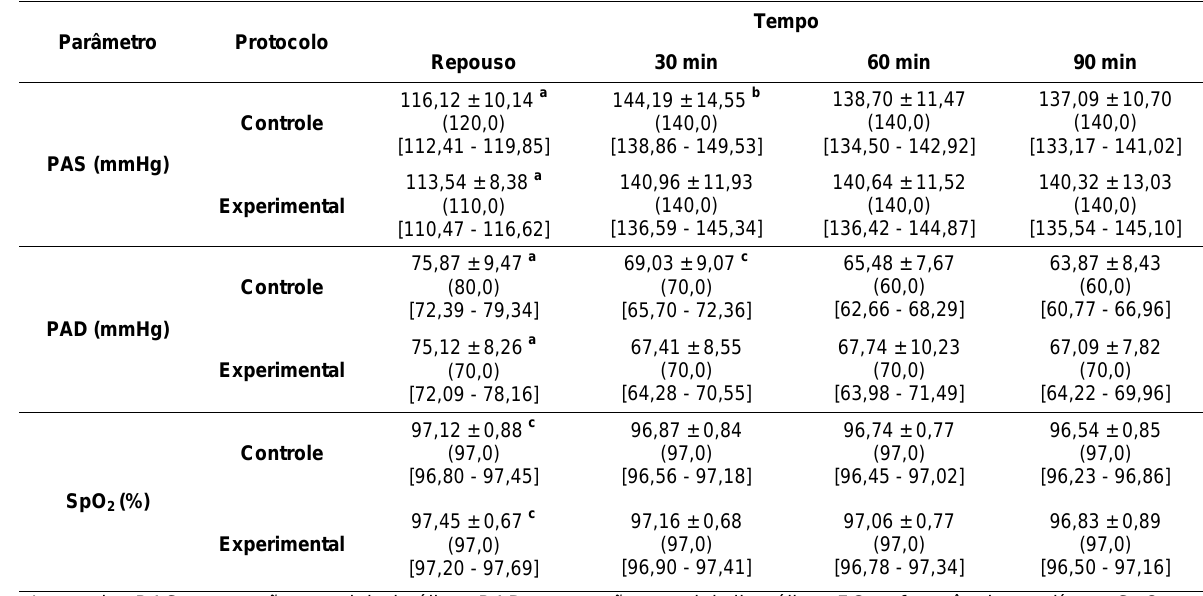
Figura1- Comportamento da frequência cardíaca (FC) durante o período de exercício (Figura 1A) e recuperação (Figura 1B) e sua comparação em relação ao repouso inicial nos protocolos controle (PC) e experimental (PE). Valores expressos como média desvios padrões. Tabela 3- Valores médios, seguidos dos seus respectivos desvios padrões, mediana e intervalo de confiança